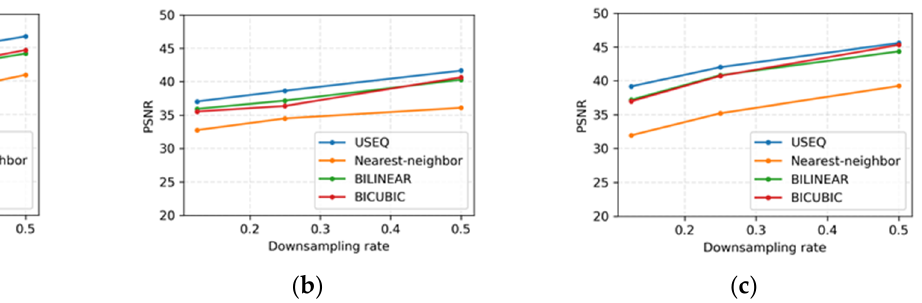
Figure 10. Segmentation results for two resizing algorithms: ( a , d , g ) are images from JSRT, LIDC- IDRI and ANH datasets; ( b , e , h ) are the segmentation result of the JSRT, LIDC, and ANH models